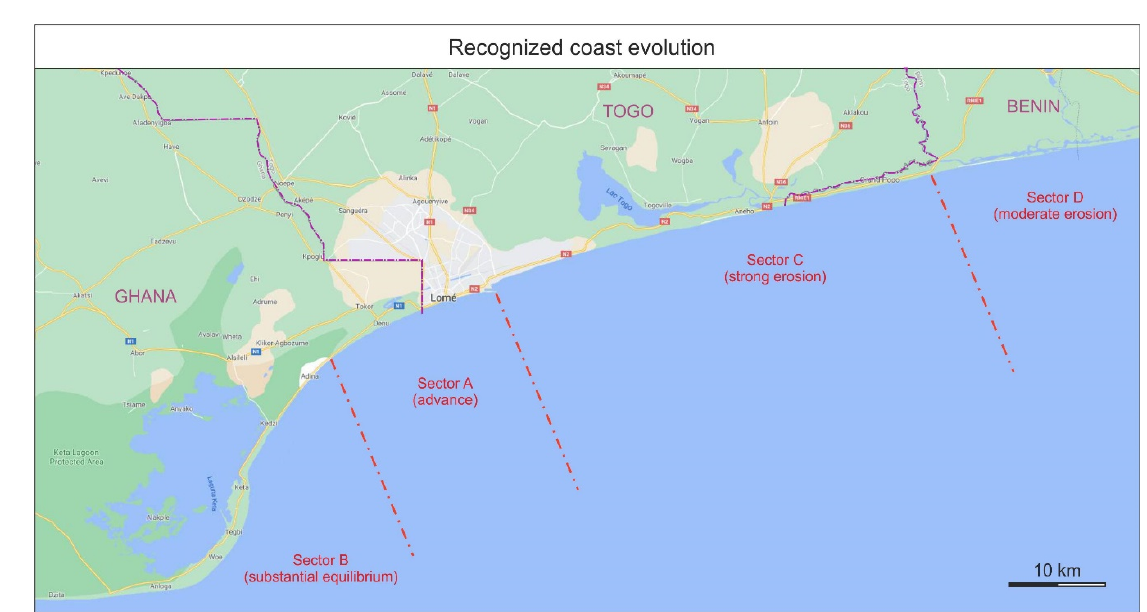
Figure 9. Different evolutionary trends (equilibrium, advance, erosion) of coastal sectors of Ghana, Togo and Benin. Sector A. This area is at present characterized by a beach advance. The main example are the beaches located to the west of the port of Lomé and in east Ghana.